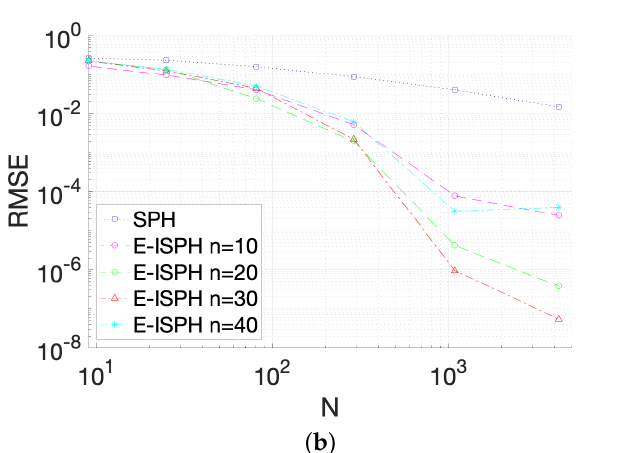
Figure 2. RMSEs versus number of data sites ( Ξ G ). ( a ) Comparison between SPH and ISPH; ( b ) com- parison between SPH and E-ISPH. All the computations are with starting normalized values and 10 ≤ n ≤ 40.